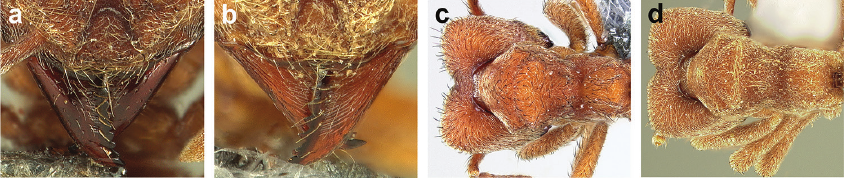
Figure 11. Mandibles and hairs. a Smooth mandibles ( S. scrobifer ) b striate mandibles ( S. saussurei ) c dorsal view of S. bondari : thick, dark hairs d dorsal view of S. amabilis : light yellow